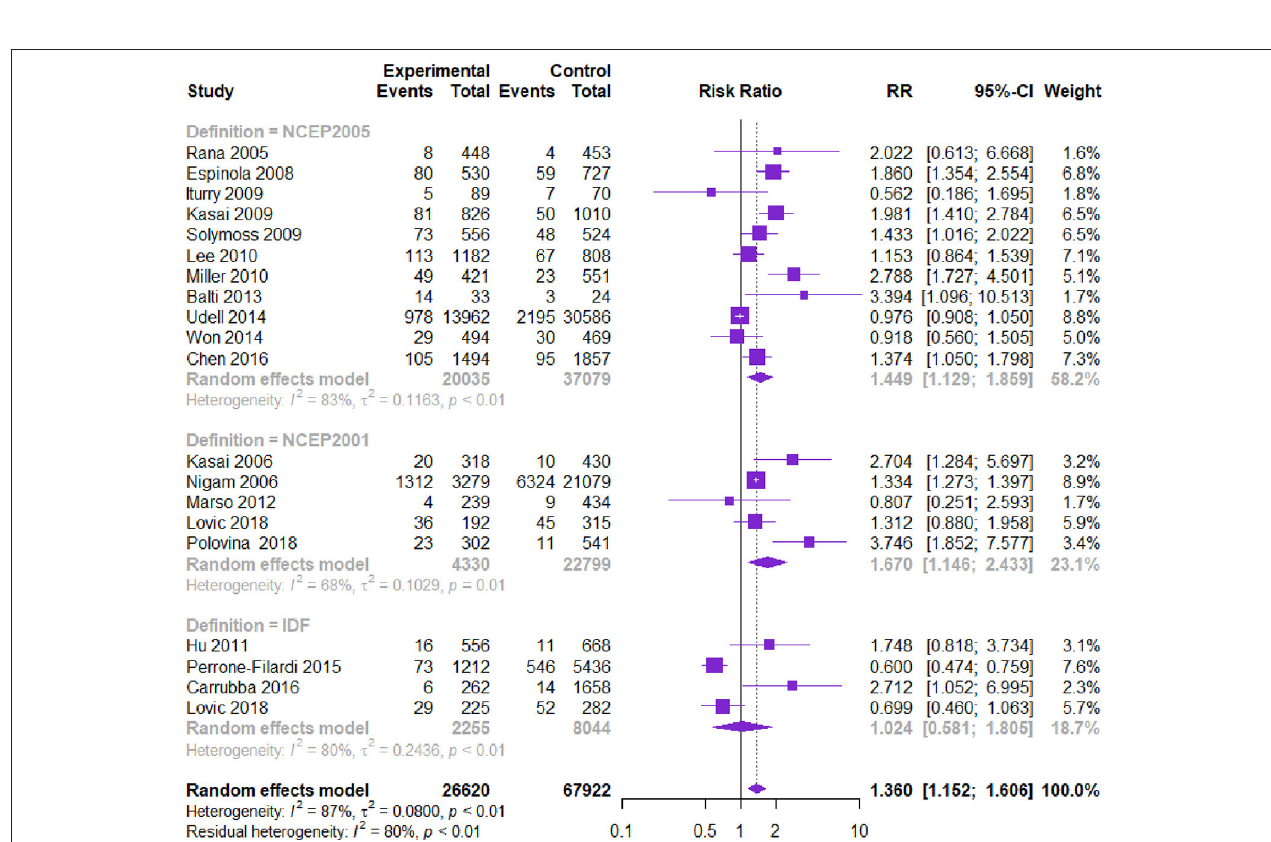
FIGURE 3 | Meta-analysis of the risk of CV death in patients with CVD and MetS compared with that of patient without MetS.